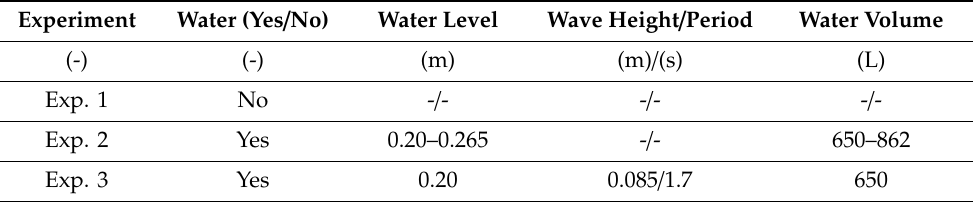
Figure 9. Frozen soil specimen of Exp. 2 in the flume on polystyrene plates exposed to the hydrostatic water level. The initial deep water depth was 0.20 m. The flume was then slowly filled with water. As the frozen specimen thawed immediately in contact with water, the filling was stopped at a water depth of 0.265 m. Small currents due to the filling process led to a wash out of the loose sediment causing high turbidity. Panels ( a )–( f ) show the filling of the flume stepwise to the water level that is indicated in each panel.